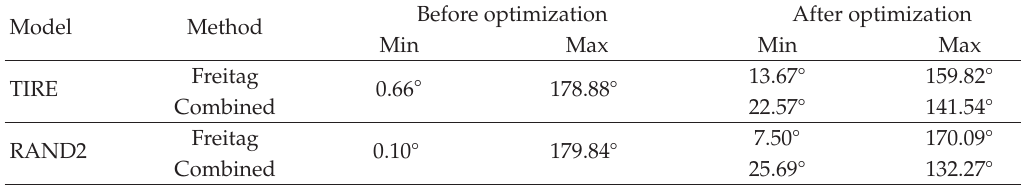
Table 3: Statistics of the examples before and after